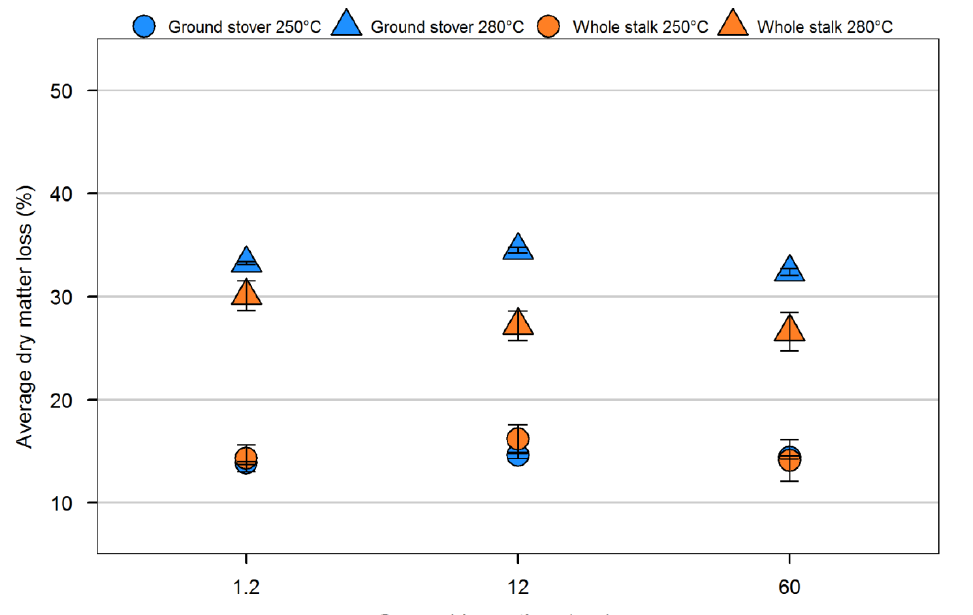
Figure 5. Average dry matter loss of torrefied ground stover and whole stalk samples (error bar = standard